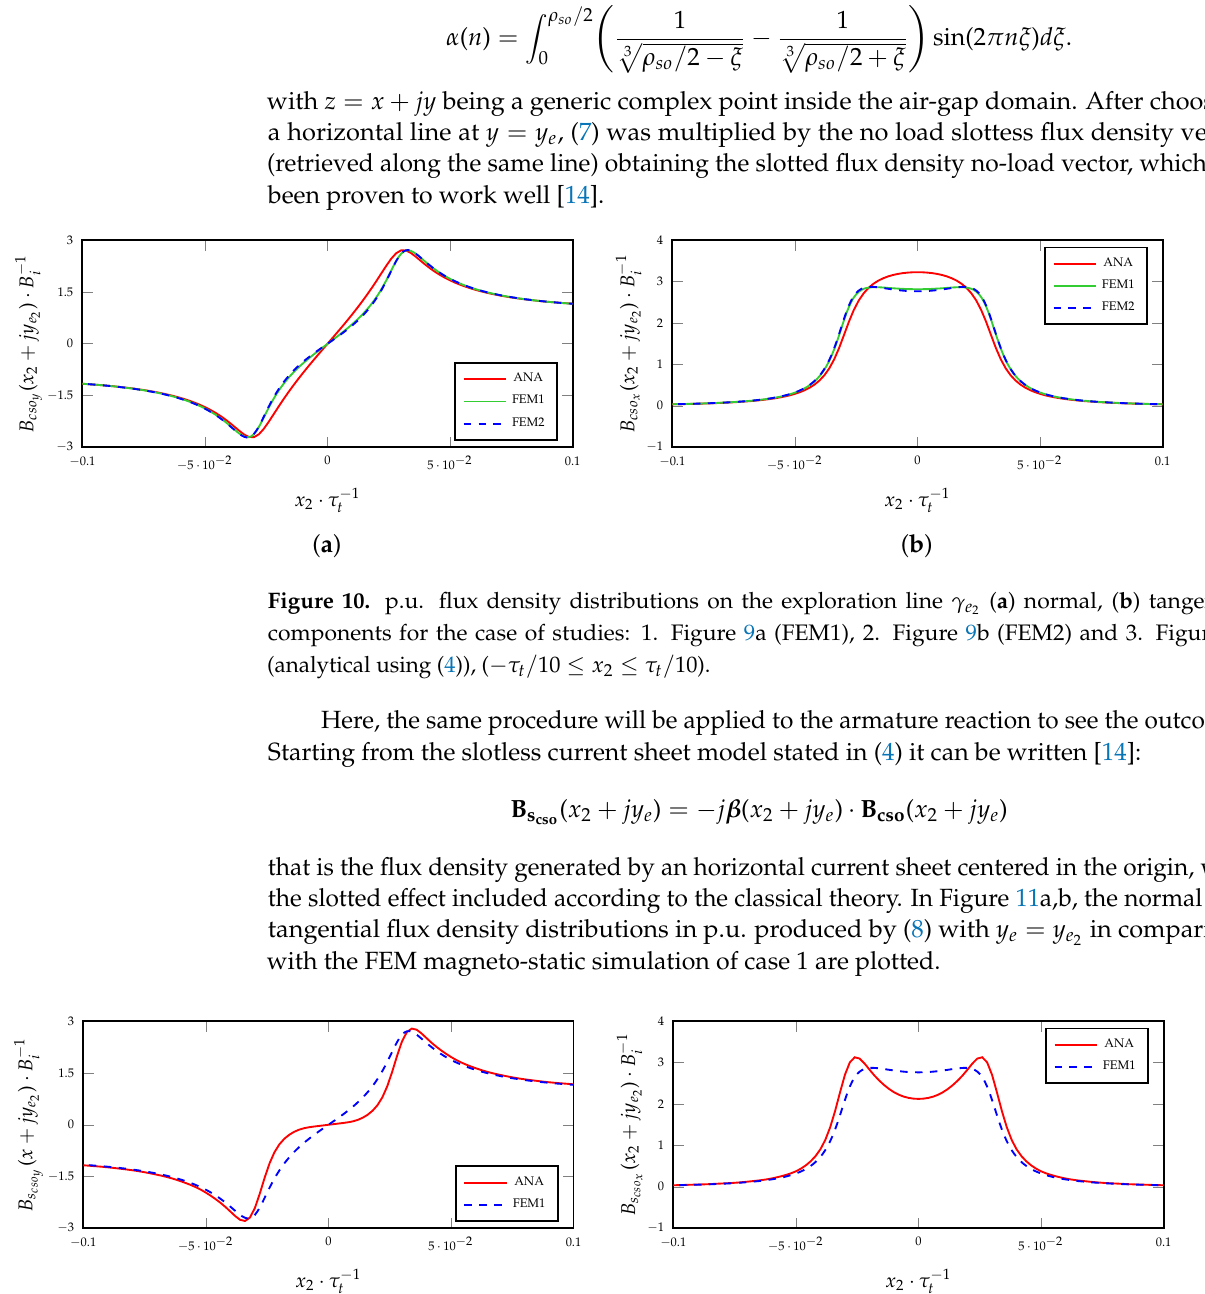
Figure 11. Analytical slotted current sheet model (8) and FEM1 flux density distributions on the explo- ration line γ e : ( a ) p.u. normal component; ( b ) p.u. tangential component ( − τ t / 10 ≤ x 2 ≤ τ t / 10). 2 It can be noticed that the application of the complex slotting function in this case does not perfectly fit the FEM pattern for both the magnetic field components and the effect